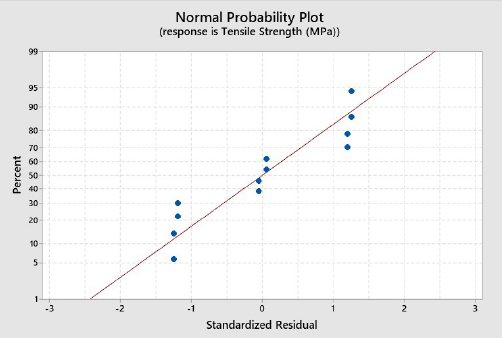
Figure 1. Normal probability plot of the residuals for the tensile strength of PP composites.